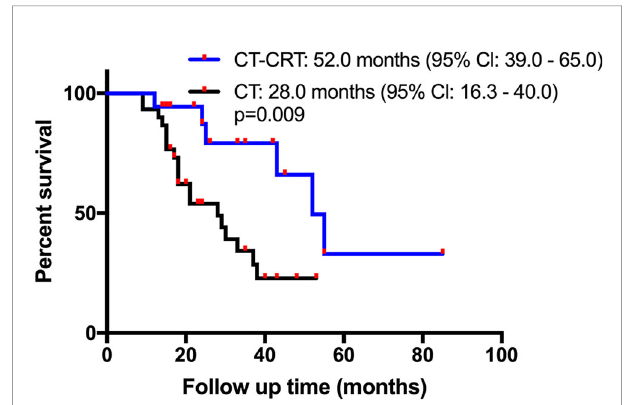
FIGURE 2 | Kaplan-Meier overall survival (OS) curves in patients with resectable pancreatic adenocarcinoma who underwent surgery and had lymph node metastasis or R1 resection after propensity score matching. Adjuvant chemotherapy (CT) vs adjuvant chemotherapy and chemoradiation